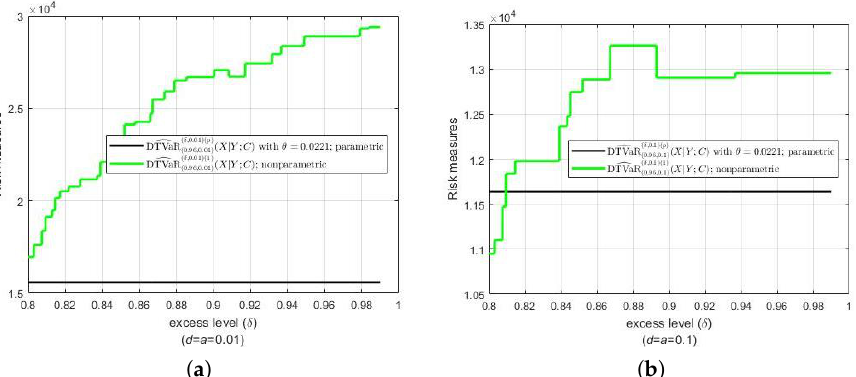
( 0.96, d ) of claim amount associated with vehicle value, in ( 0.96, a )